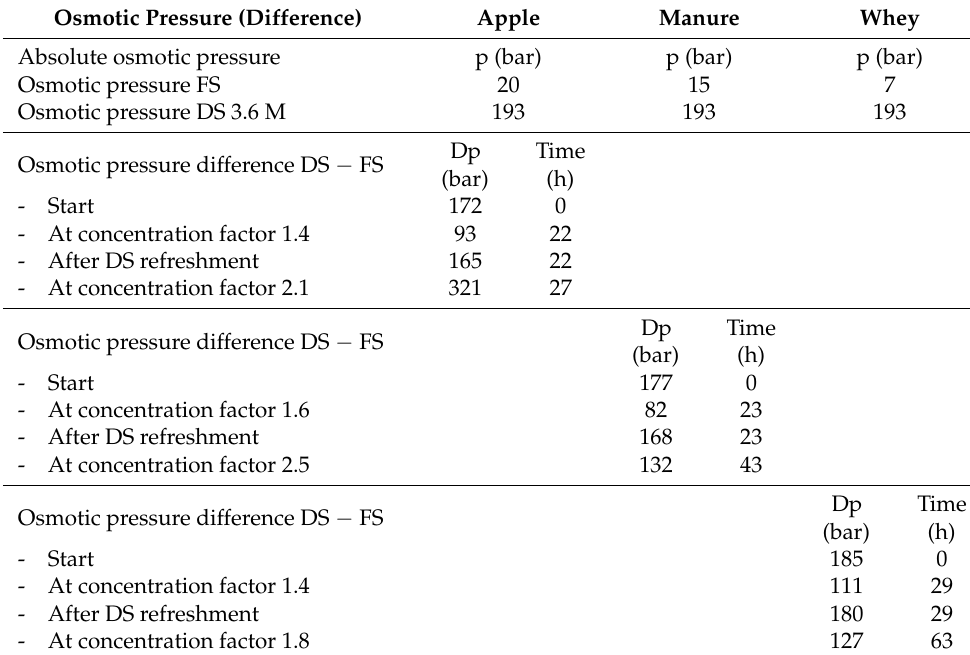
Table 3. Osmotic pressures of the starting solutions and the effective osmotic pressure during the different stages in time of the concentration process for apple juice, manure and whey